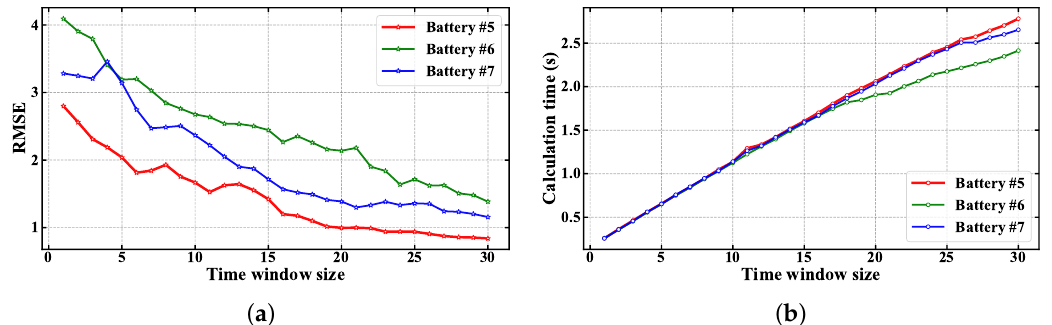
Figure 11. Results of experimental case 2. The RUL prediction results of Batteries #5, #6 and #7 when using the PSO-GBDT method with different window sizes: ( a ) RMSE at different window sizes. ( b ) The total calculation time required for training and prediction at different window sizes.